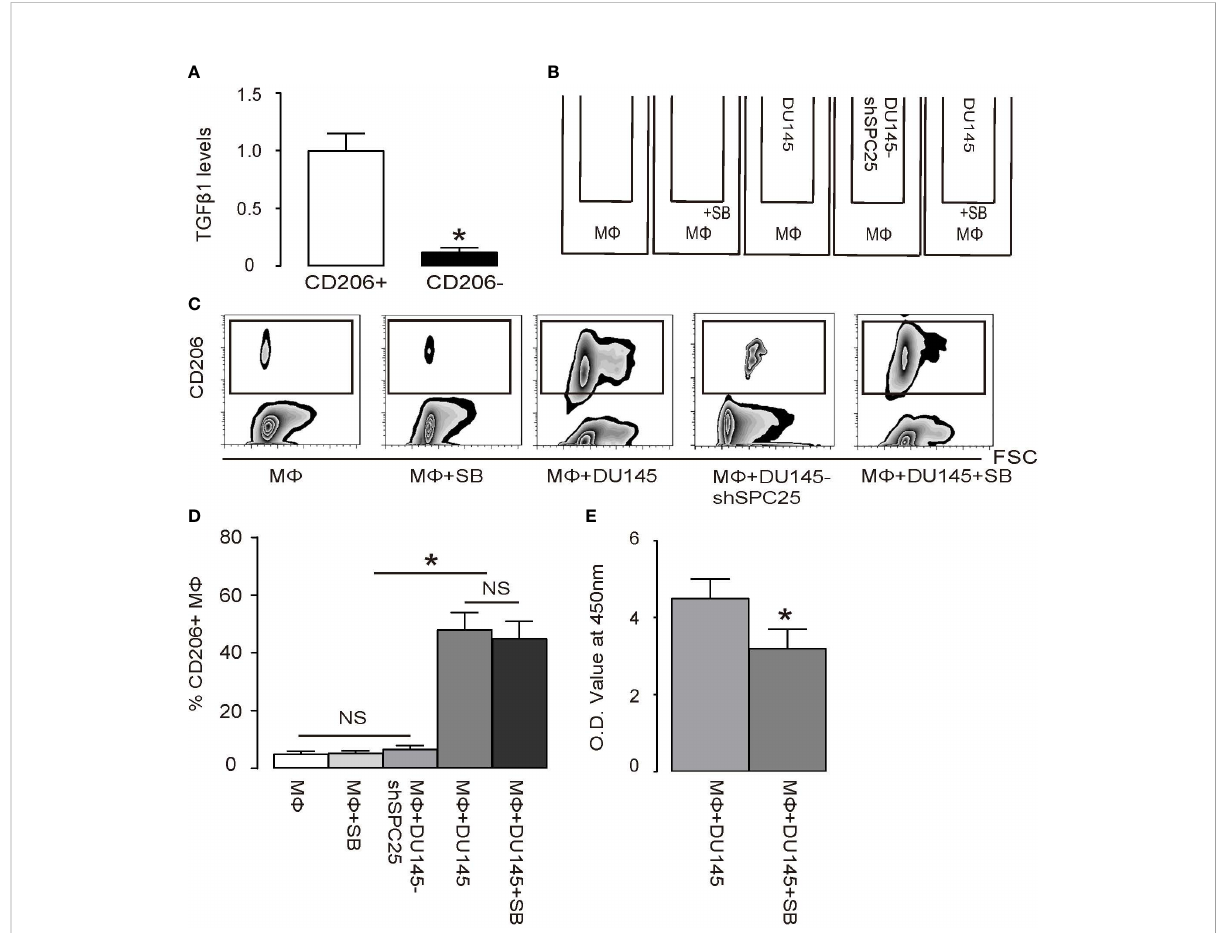
FIGURE 5 Polarized TAMs promote PrC cell growth through TGF b 1 (A) RT-qPCR for TGF b 1 mRNA level in CD206+ versus CD206- macrophages. (B) A transwell co-culture diagram of DU145 cells and bone-marrow-derived macrophages (M F ). Group 1: M F . Group 2: M F with inhibitor SB431542 (SB). Group 3: M F and DU145 cells. Group 4: M F and DU145 cells transduced with shSPC25. Group 5: M F and DU145 cells with SB. Cells were incubated for 2 days. (C, D) Flow cytometry analysis of CD206+ cells in macrophages, shown by quanti fi cation (C) and by representative fl owcharts (D) . (E) MTT assay on DU145 cells. * p < 0.05. NS, non-signi fi cant. n =